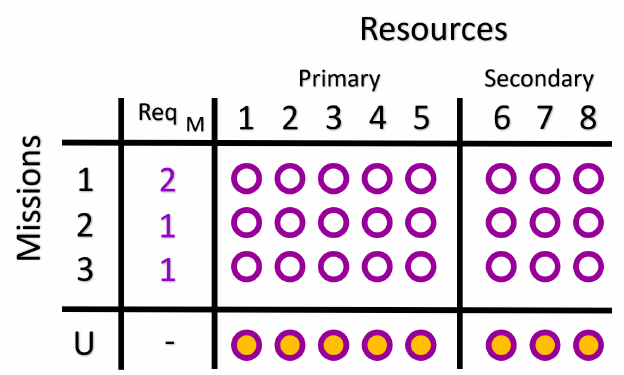
Figure 3. Example Initial State: All resources are initialized to be unallocated, or allocate to mission U , the last row.